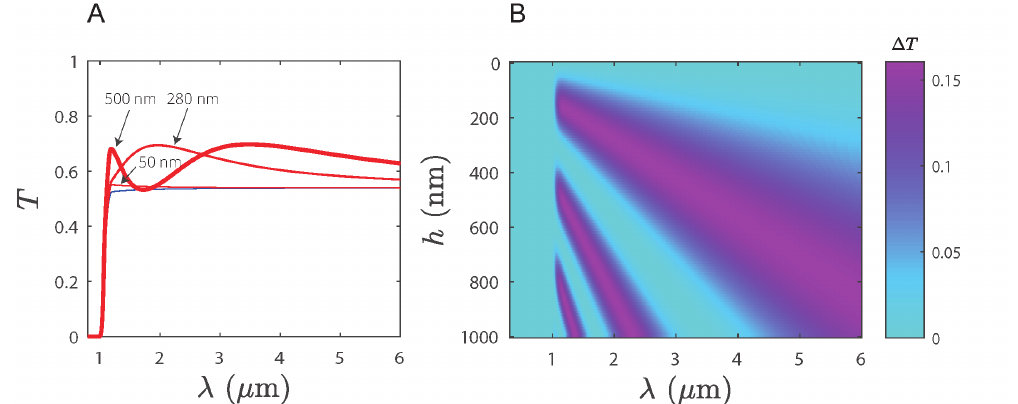
Figure 11. ( A ): Transmittance T calculated for a nanoporous CeO 2 coatings of variable thickness h (red curves) deposited on a silicon substrate (blue curve). ( B ): Transmittance excess ∆ T = T Si+coat − T Si as a function of wavelength and coating thickness h